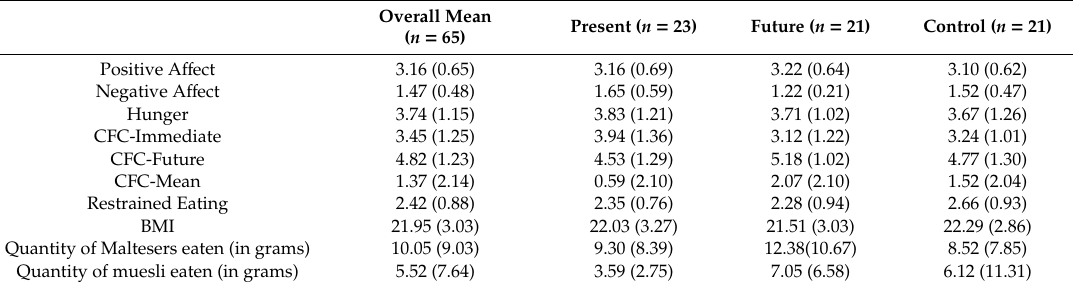
Table 1. Descriptive statistics of Experiment